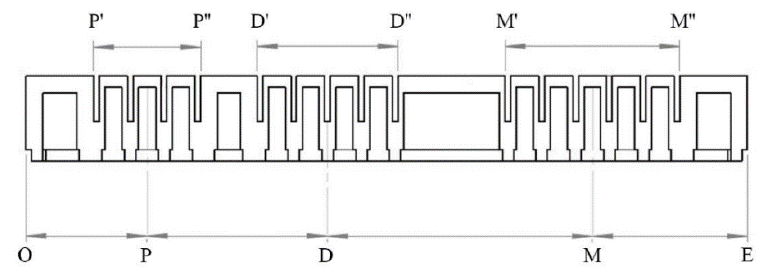
Figure 9. The customization scheme of actuator size.